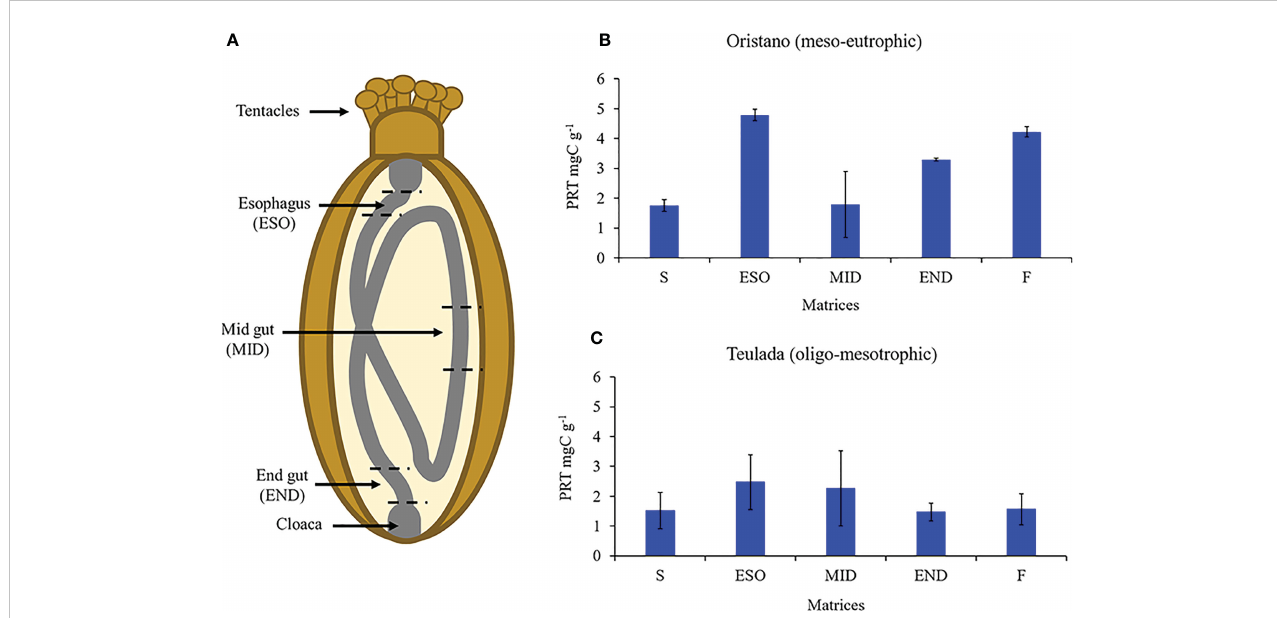
FIGURE 5 Schematic representation of sea cucumbers ’ digestive tract (A) . Protein contents (PRT) of source sediment (S), sediment in the esophagus (ESO), mid gut (MID), and end gut (END) and feces (F) of holothurians from the meso-eutrophic site (Oristano, B ) and from the oligo-mesotrophic site (Teulada, C ). Error bars indicate standard error (n=9 S; n=3 ESO; MID; END;